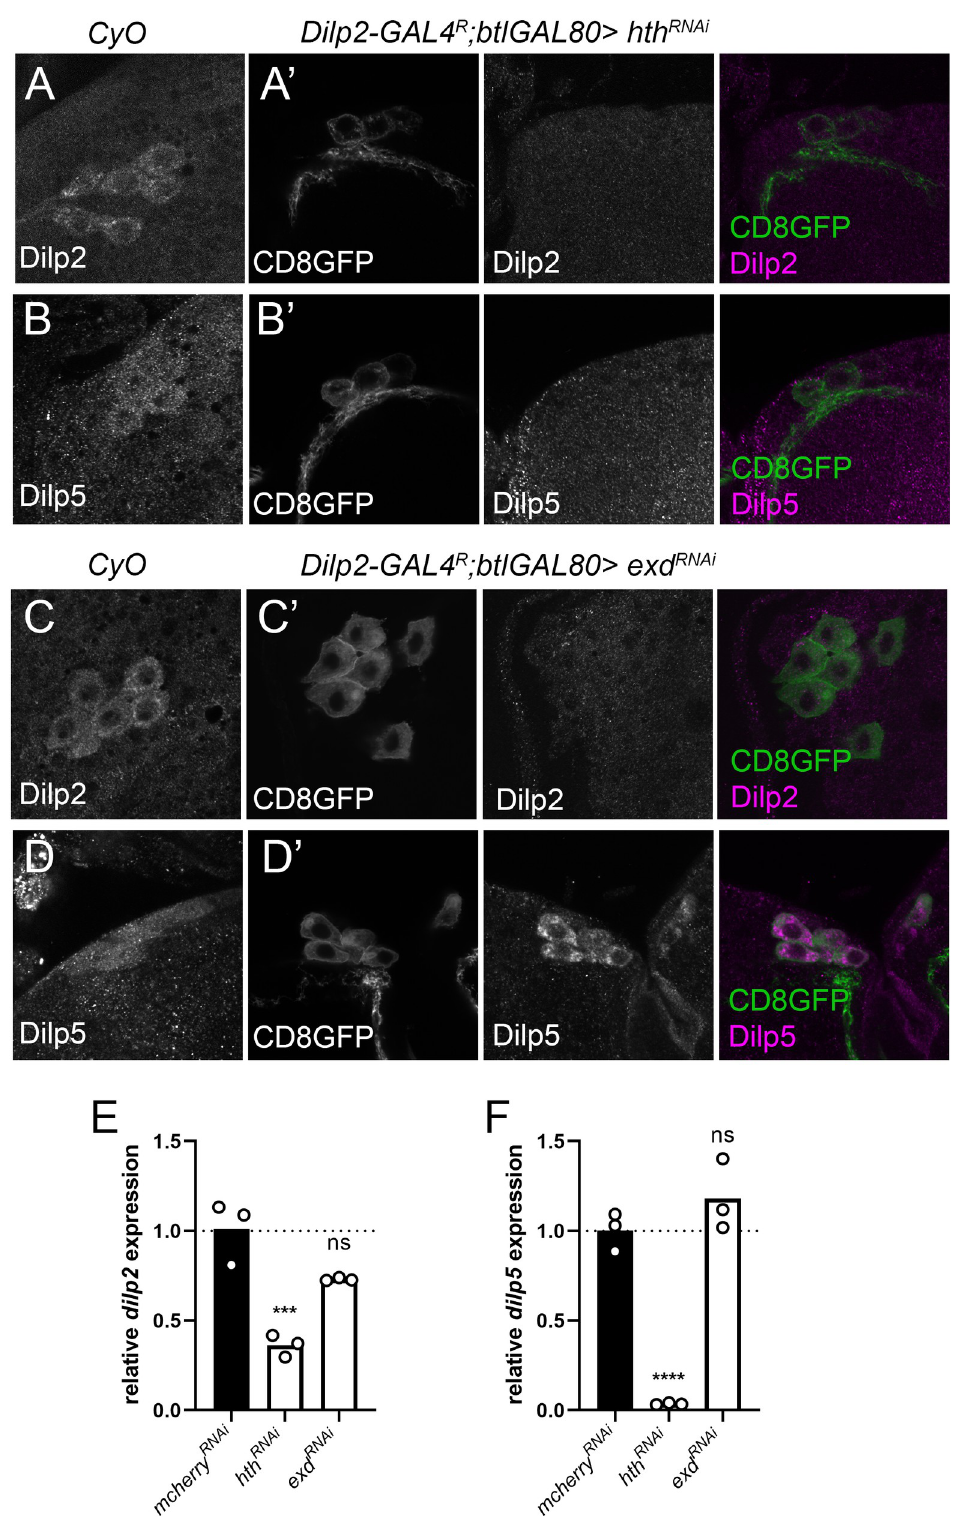
Fig 6. Hth and Exd have differing effects on Dilp protein and mRNA levels in late L3. (A-A’, B-B’) representative images showing reduced Dilp2 and Dilp5 protein levels in late L3 (100h after egg laying) larvae genetically depleted of hth compared to balanced sibling controls (CyO, left panels). (C-C’, D-D’) IPC-specific exd knockdown results